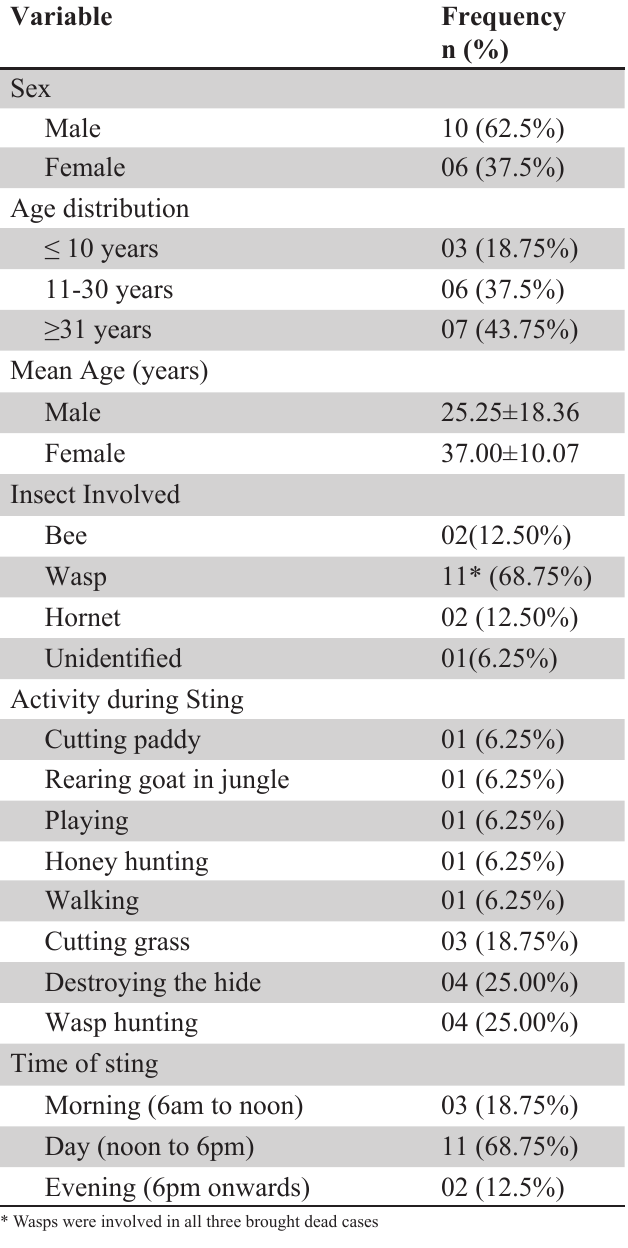
Table 1. Demographic characteristics of the patients.